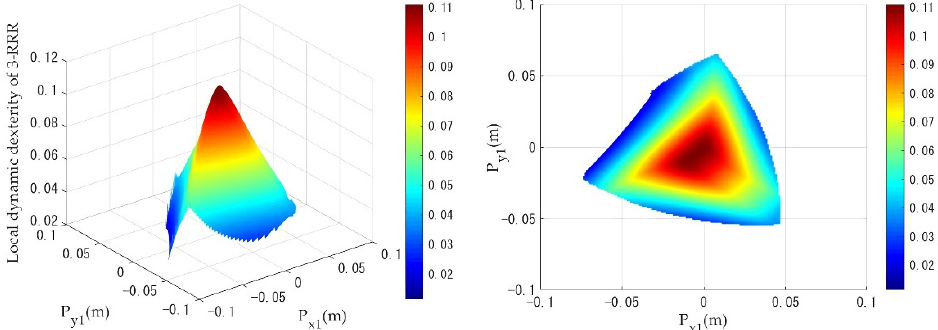
Figure 12. Distribution of the local dynamic dexterity of the 3-RRR PPM under a linear trajectory.